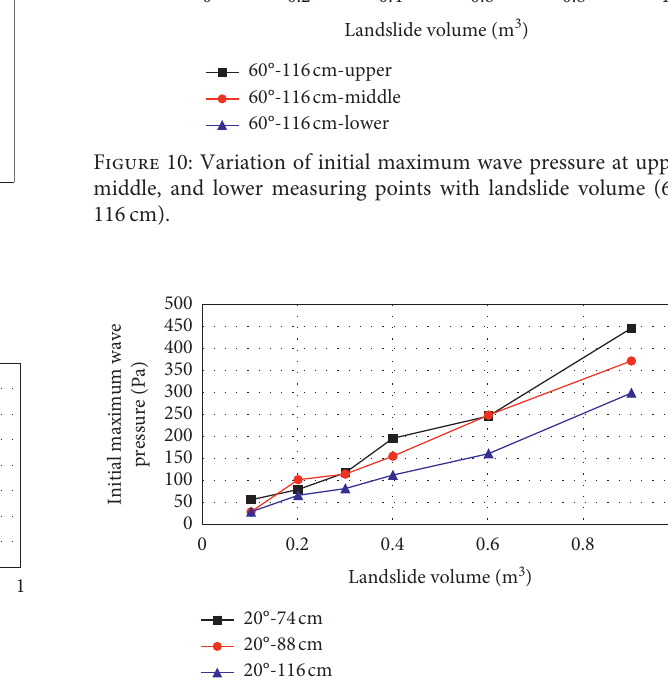
Figure 11: Variation of initial maximum wave pressure with landslide volume at three water depths (at 20 ° ).